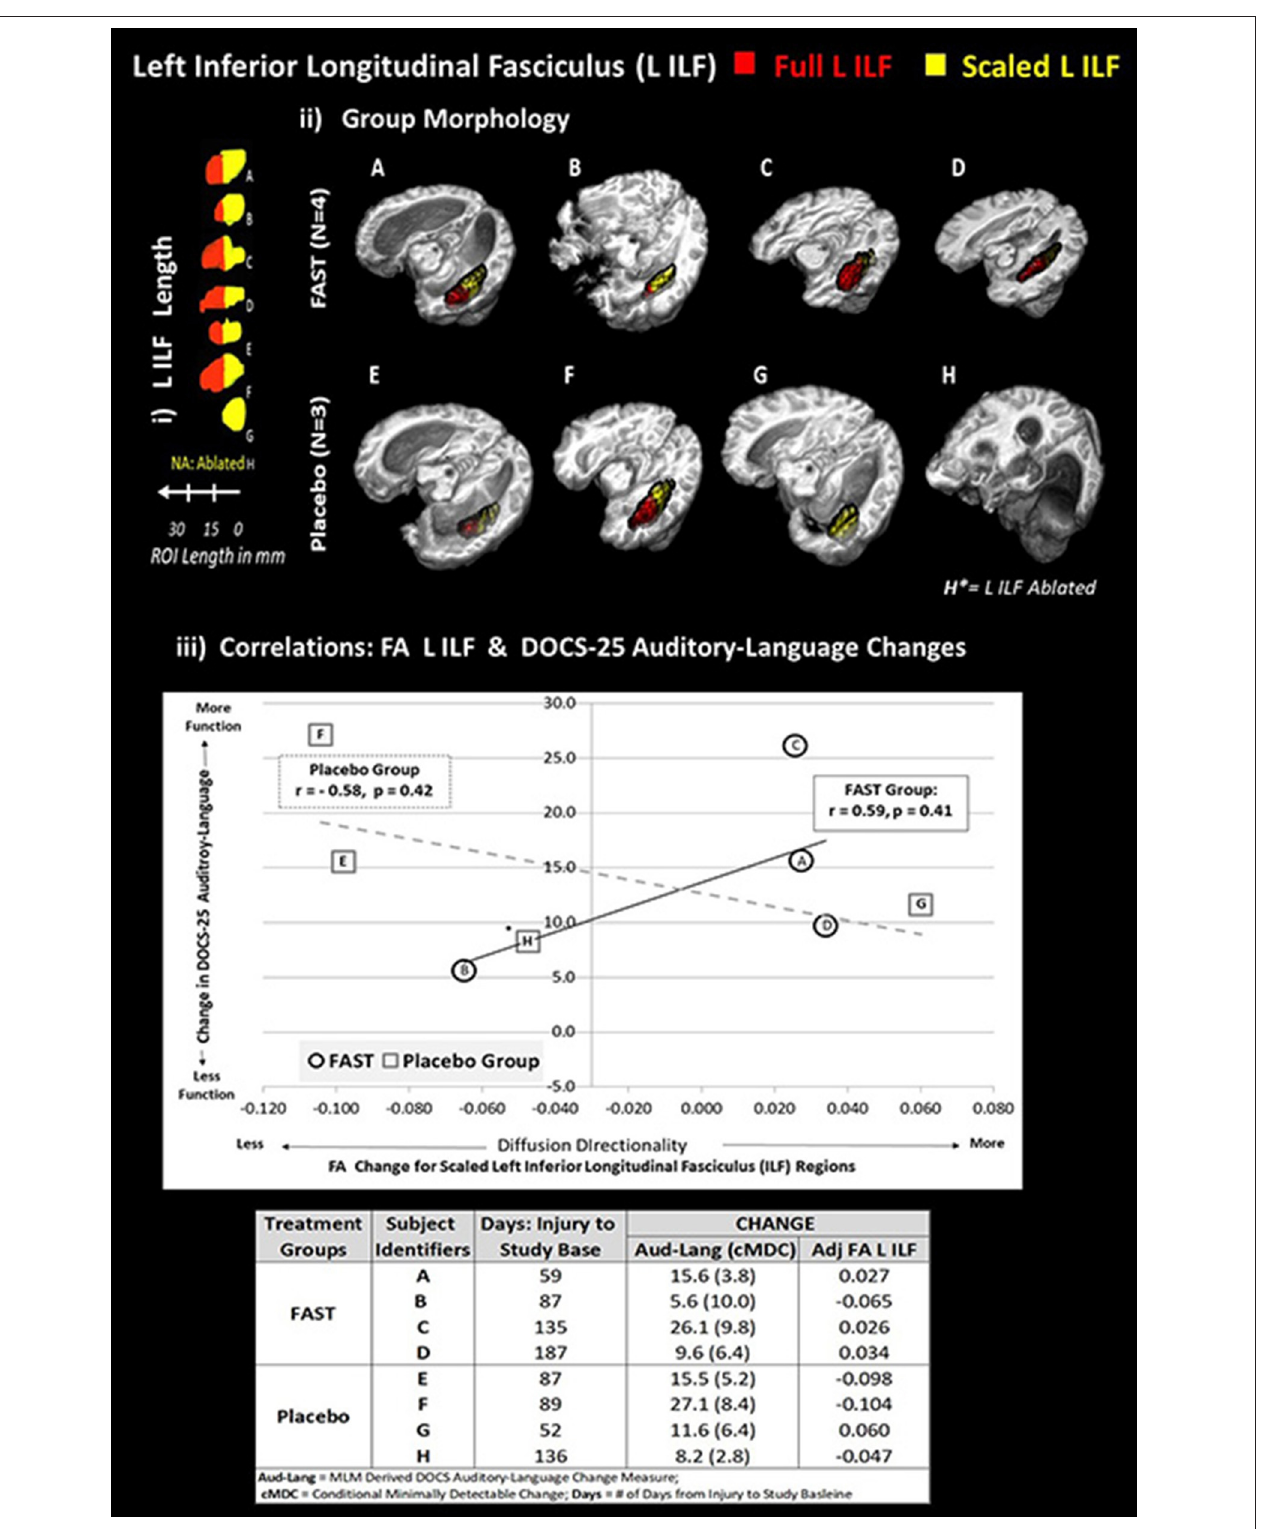
FIGURE 3 | Each subject’s left ILF by group and correlation with DOCS-25 auditory-language measures. The top half of figure illustrates the full left ILF, depicted in red and adjusted left ILF, depicted in yellow. Panel i shows the length in millimeters (mm). Panel ii demonstrates the group-level morphology in native space. To standardize the amount of substrate, relative brain size, and location of the ILF comparisons, an adjusted portion of each subject’s left ILF was used to compare FA